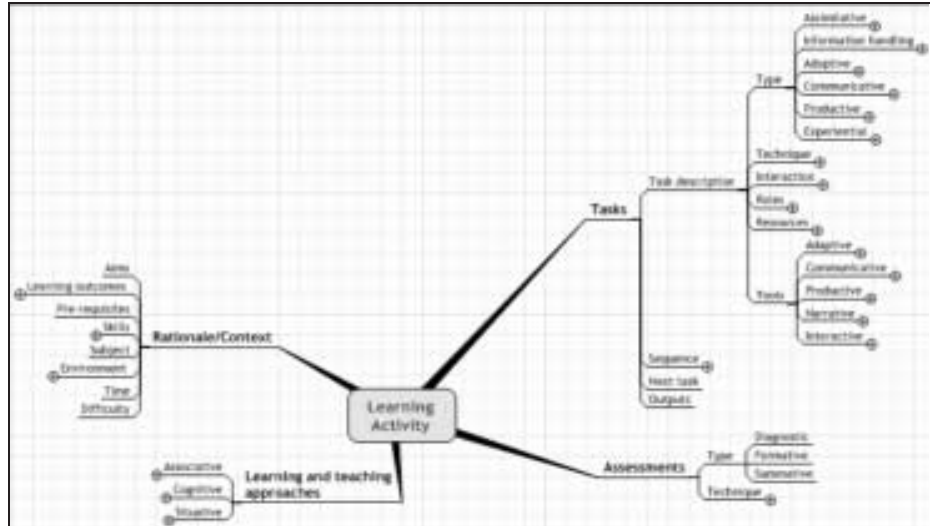
Figure 2. Specification of a learning